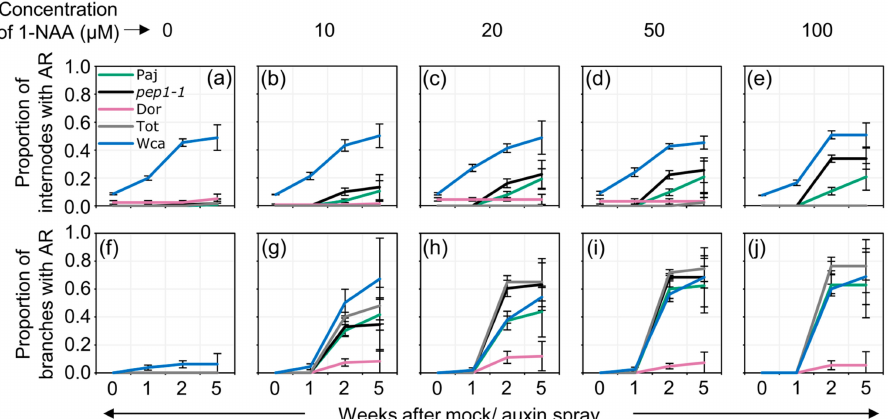
Figure 4. Auxin spray induces adventitious roots in a dosage- and genotype- dependent manner. Paj, pep1-1 , Dor, Tot and Wca were sprayed after six weeks in LD with 0 µ M, 10 µ M, 20 µ M, 50 µ M and 100 µ M 1-NAA. Nine plants were scored for each treatment. Plants were scored before spraying and one, two and five weeks after auxin spray. ( a ) Proportion of internodes on the main stem and ( b ) axillary branches occupied with adventitious roots after 1-NAA spray relative to before spray. The data and statistical analyses are tabulated in Tables S7–S9. A second replicate is presented in Figure